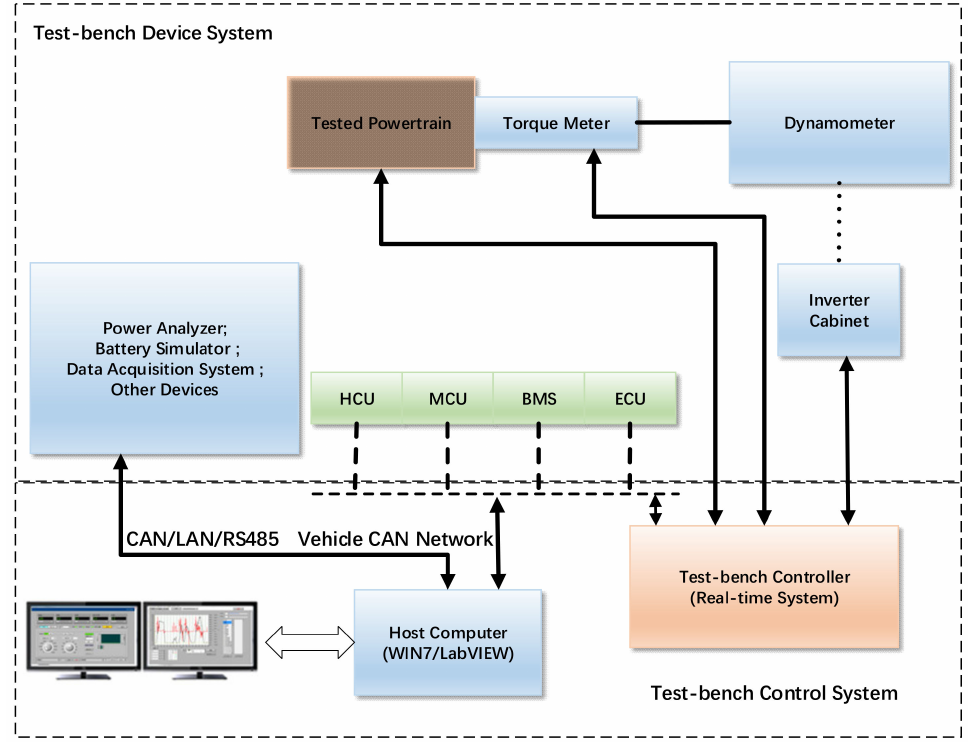
Figure 1. The layout of a single dynamometer test-bed for the hybrid electric vehicle